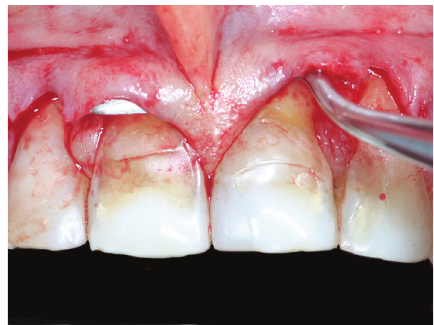
Figure 7: Interincisive papilla is tunneled.